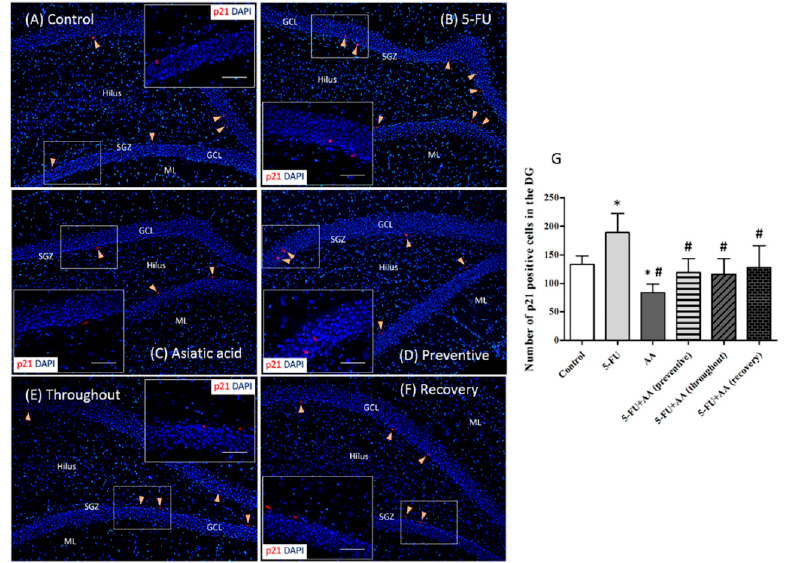
Figure 3. Images of p21 positive cells (red) in the dentate gyrus ( A – F ). All nuclei were stained with DAPI (blue). In the SGZ, p21 positive cells were indicated by arrowheads (scale bars 100 µ m).